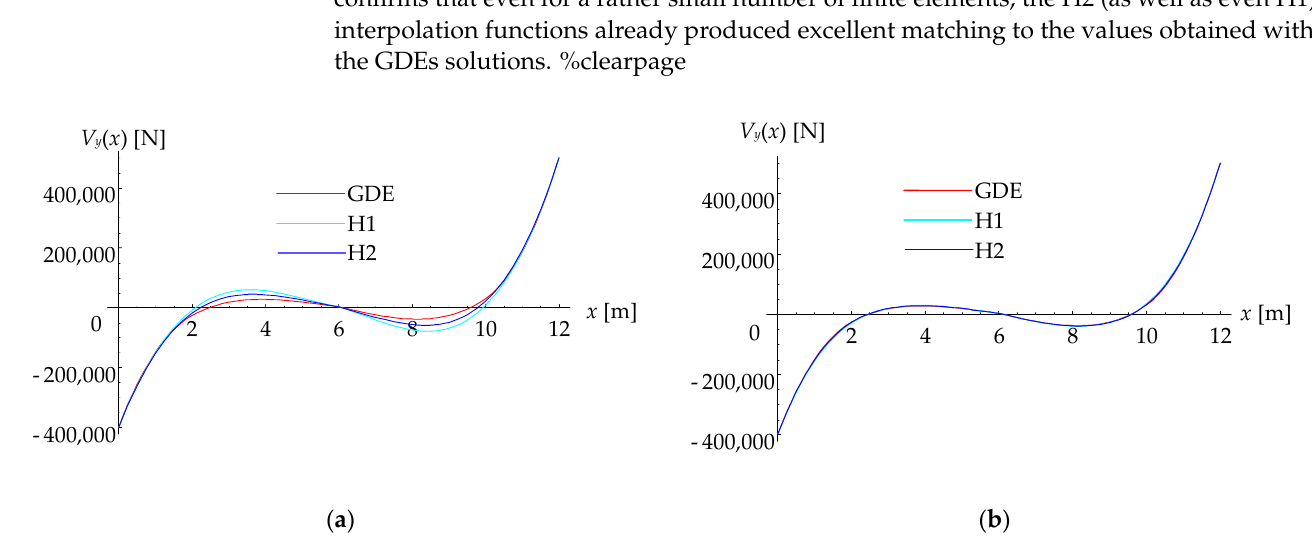
Figure 5. Comparison of shear forces for two ( a ) and four ( b ) FE meshes, respectively.